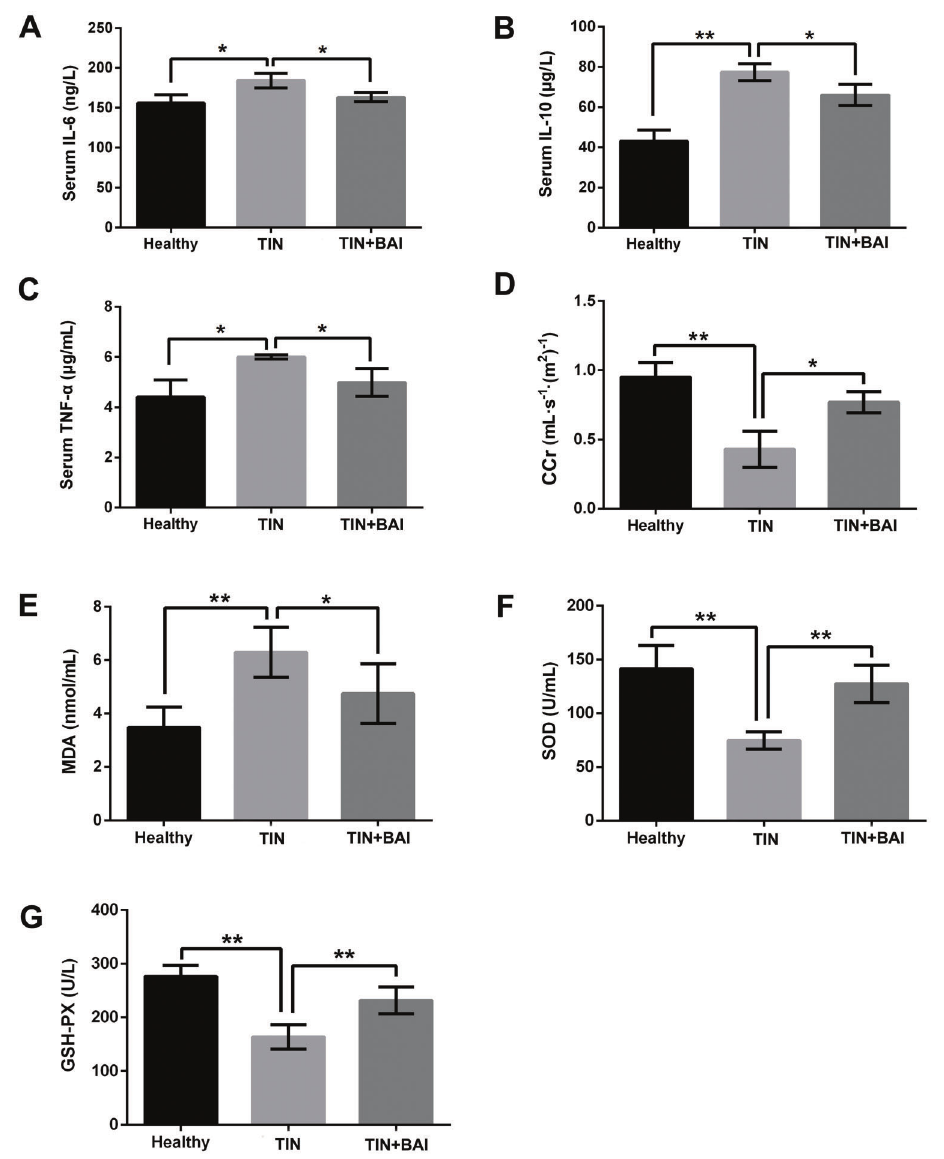
Figure 1. A – C , BAI treatment reduced the levels of IL-6, IL-10, and TNF- a in serum of TIN patients. D , BAI treatment enhanced the patient ’ s CCr. E – G , BAI treatment reduced the activity of MDA and enhanced the activities of SOD and GSH-PX in serum of TIN patients. BAI: baicalein; TIN: tubular-interstitial nephritis; IL-6: interleukin-6; IL-10: interleukin-10; TNF- a : tumor necrosis factor- a ; CCr: creatinine clearance; MDA: malondialdehyde; SOD: superoxide dismutase; GSH-PX: glutathione peroxidase. Data are reported as means ± SE. *P o 0.05, **P o 0.01